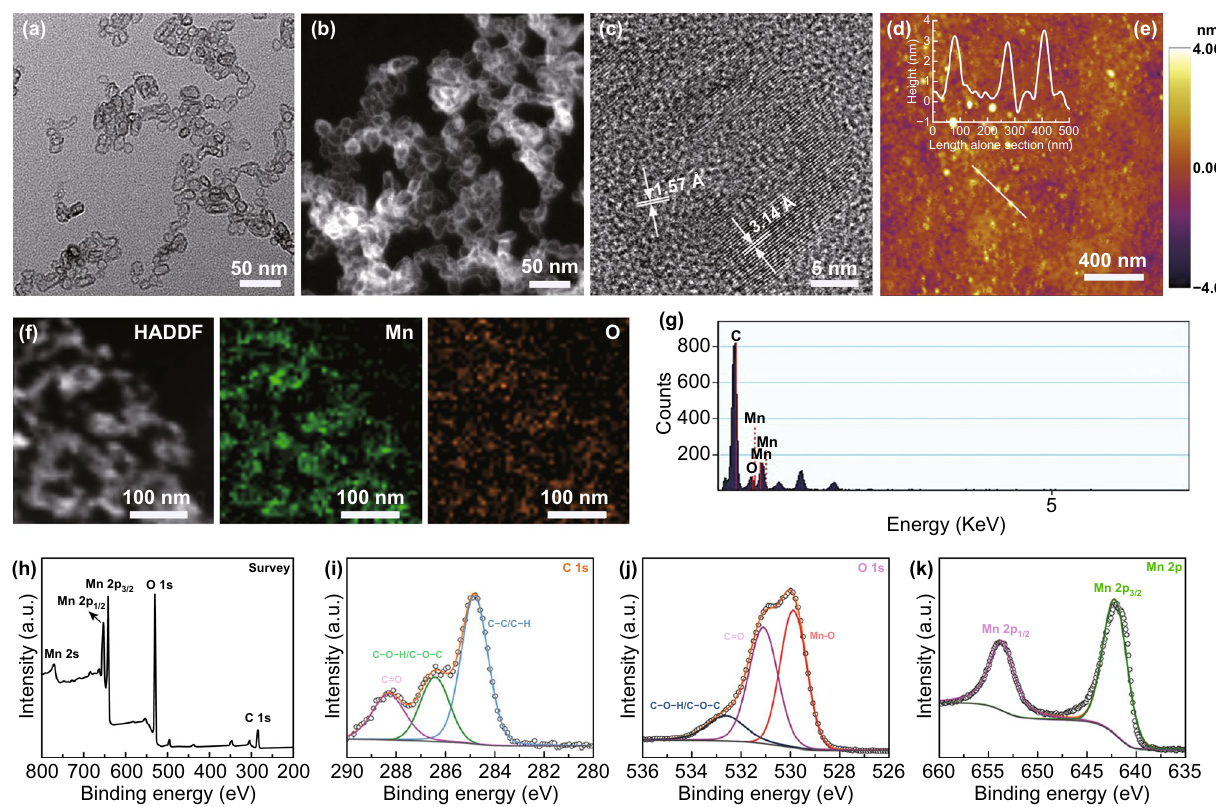
Fig. 2 a TEM, b and f HADDF-STEM, c high-magnification TEM, d and e AFM height images of PAA 68 – b –PEG 86 – b –PAA 68 /MnO 2 . g EDS, h XPS, and high-resolution (HR) XPS spectra of i C 1 s , j O 1 s , and k Mn 2 p of PAA 68 – b –PEG 86 – b –PAA 68 /MnO 2 are